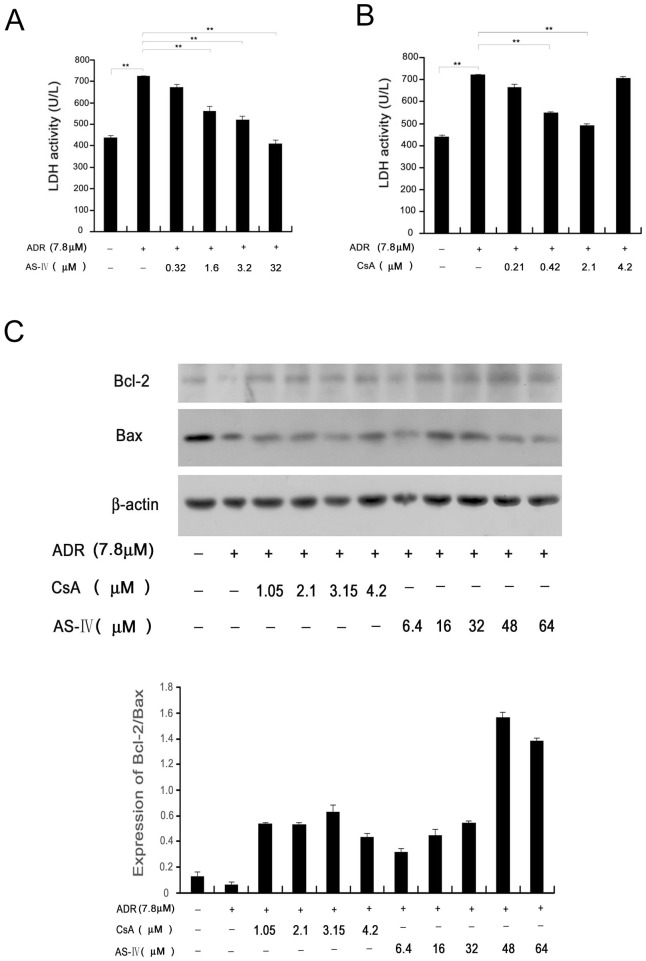
The protective effect of AGS-IV in adriamycin-induced injury of cardiomyocytes compared with CN inhibitor CsA.(A) Activity of LDH in culture supernatant of the ADR-injured cardiomyocytes treated by AGS-IV (0.32∼32 µM). (B) Activity of LDH in culture supernatant of the ADR-injured cardiomyocytes treated by CsA (0.21∼4.2 µM). Data are shown as mean±SD (n = 4) (**P<0.01). (C) The effects of CsA and AS-IV on the expressions of apoptotic proteins. The expression of BCL-2 and Bax in ADR-injured cardiomyocytes treated by CsA or AGS-IV, the effects of CsA and AS-IV on the Bcl-2/Bax level. All data are mean±SD (n = 3).